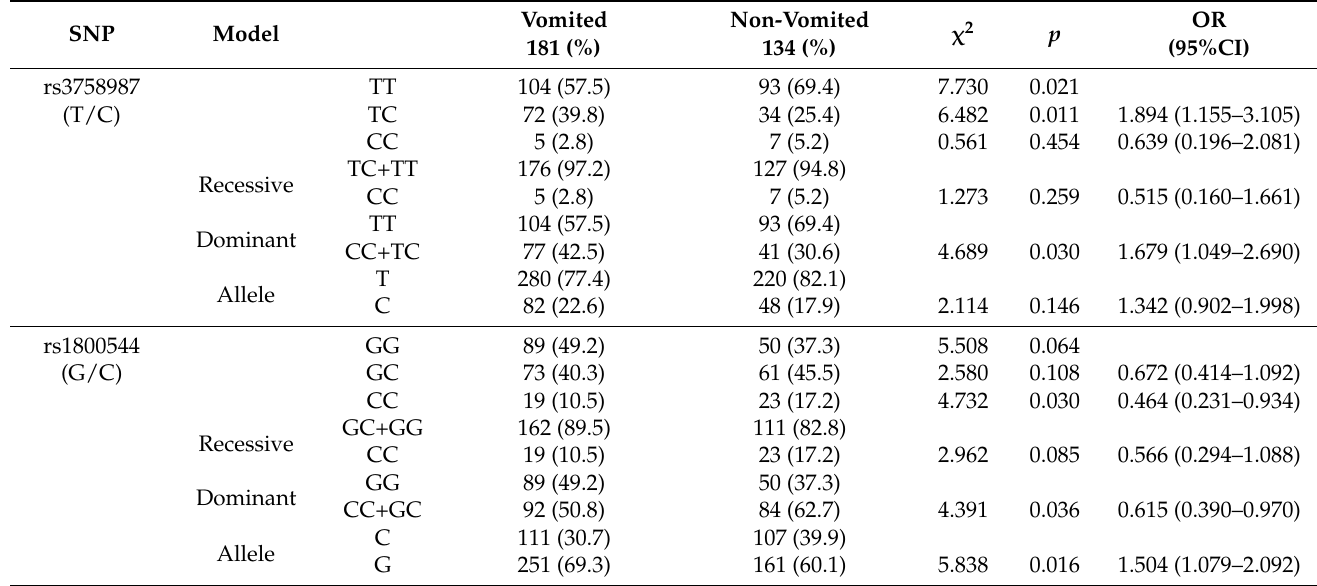
Table 3. The HTR3B rs3758987 and ADRA2A rs1800544 gene polymorphisms and risk of motion sickness induced-vomiting in childhood.